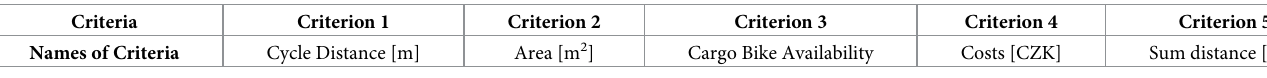
Table 8. Initial criteria for a decision-making process.